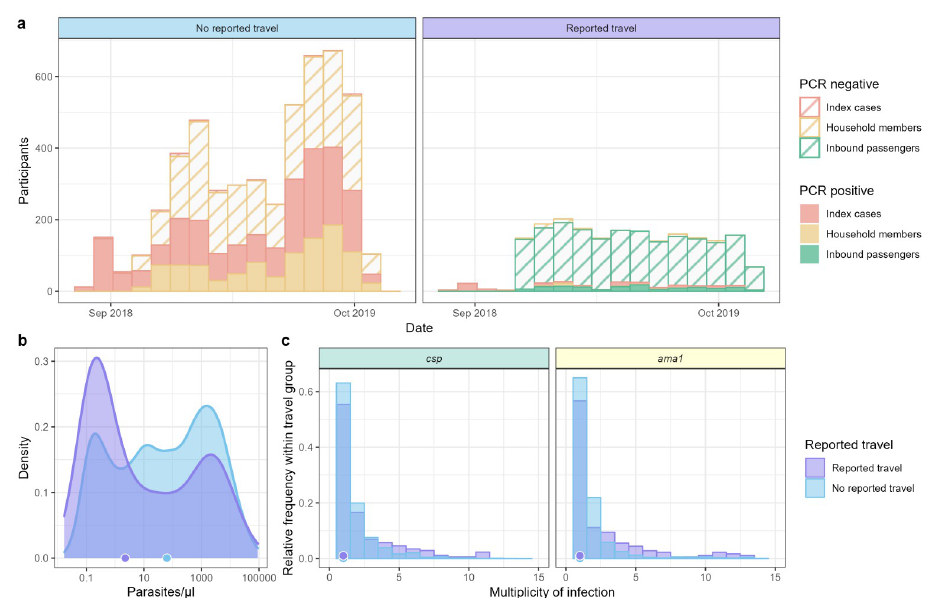
Fig 2. Plasmodium falciparum cases, parasite density, and multiplicity of infection in index cases, household members, and inbound passengers, stratified by reported travel. (a) P . falciparum PCR-positive (solid) and negative (striped) participants by reported travel and case type throughout the study. (b) Parasite density distribution by reported travel. Points on x-axis represent median parasitemias for each group. (c) Multiplicity of infection determined by csp (left) and ama1 (right) haplotype counts in each individual. Points on x-axis represent median MOIs for each case type.